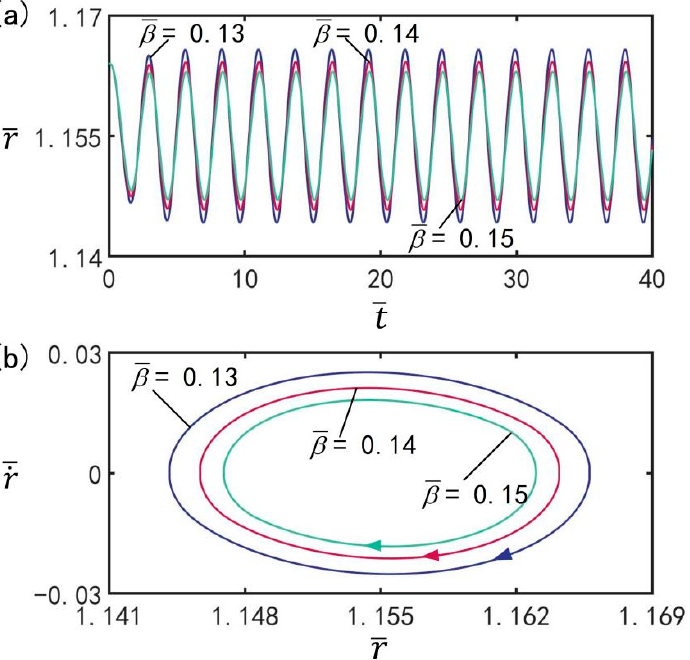
β Figure 12. The effect of damping coefficient β on the beating of LCE balloon. ( a ) Time histories; Figure 12. The effect of damping coefficient on the beating of LCE balloon. ( a ) Time histories; ( b ) Limit cycles. The parameters are T on / T L = 0.5, T L = 2.7, I = 0.5, C 0 = 0.3, n I = 0.45 ( r I = 1.164 ) , ( b ) Limit cycles. The parameters are = 0.18, and . r = 0. With increasing damping coefficient, the beating V L = 0.05, ρ = 0.16, p I ext amplitude